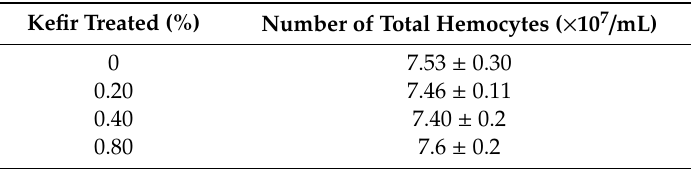
Table 3. The number of total hemocytes in L. vannamei by treatment of fermented